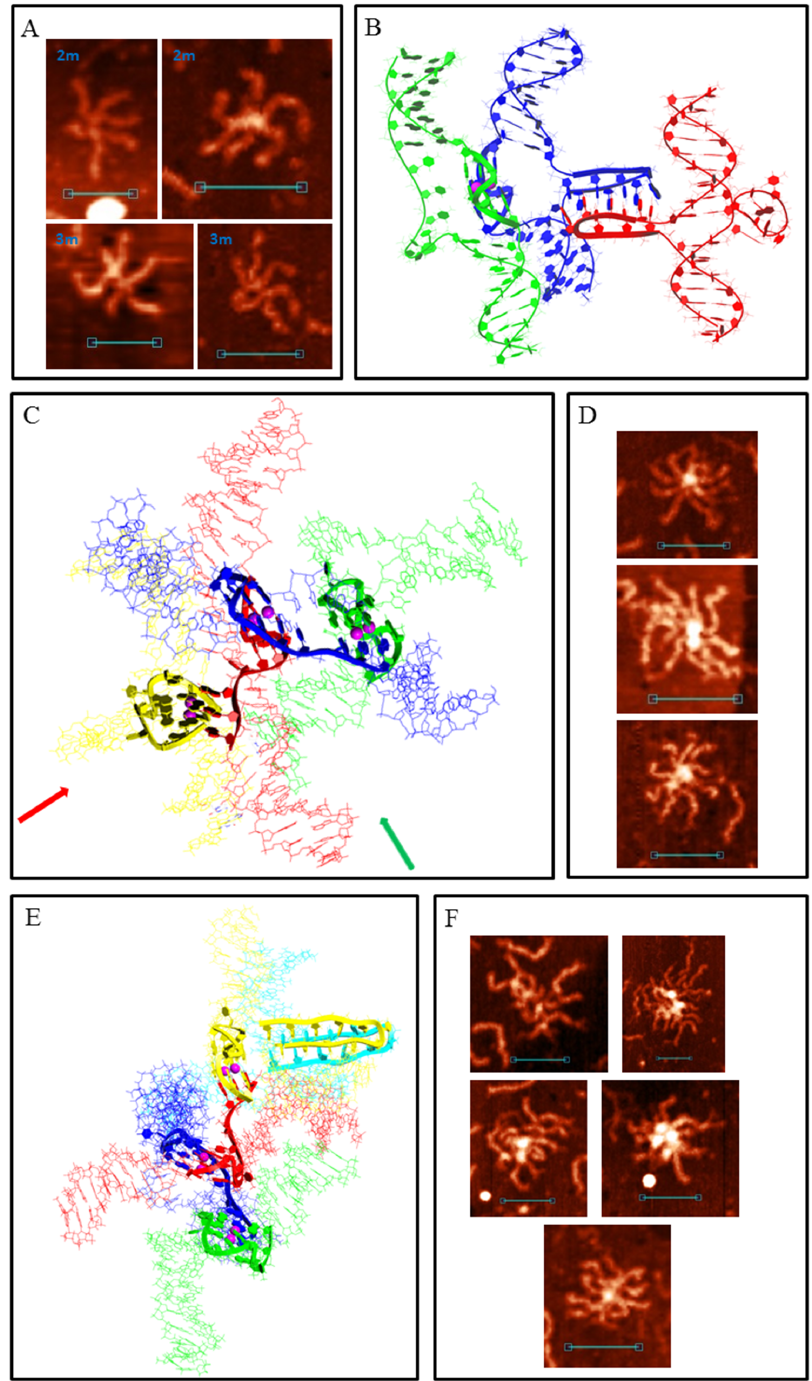
Figure 4. Multimeric G4/IM-synaptic complexes formed by 2m and 3m samples. ( A ) Examples of trimolecular complexes formed through intermolecular G4 and IM folding. Scale bars: 50 nm. ( B ) Molecular model of the structure, consistent with ( A ). ( C ) Molecular model of the tetrameric complex formed by 3m sample through the formation of three intermolecular G4s. The red and green arrows show the viewpoints from which the complexes are visible in the following examples. ( D ) Examples of the tetrameric complexes, revealed by AFM. Scale bars: 50 nm. ( E ) Molecular model of the synaptic complex formed by additional duplex joining with the previous structure through intermolecular IM formation. ( F ) Examples of the complexes, consistent with model ( E ), revealed by AFM. Bottom image represents the only example of the complex that remained intact (was not disrupted) during the AFM experiment. Scale bars: 50